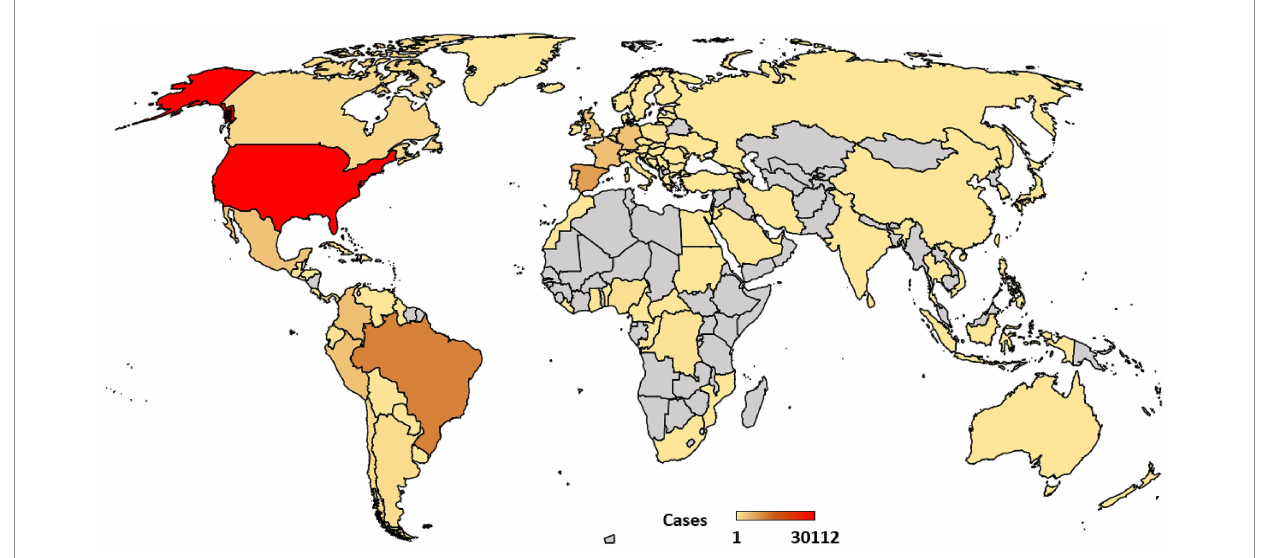
FIGURE 1 Geographical distribution of Mpox caseload as of January 31, 2023 (confirmed cases only). Data source—United States Centers for Disease Control and Prevention (U.S. CDC; https://www.cdc.gov/poxvirus/monkeypox/response/2022/world-map.html; accessed February 1, 2023). Note that the map is only for illustrative purposes and the authors remain neutral regarding territorial